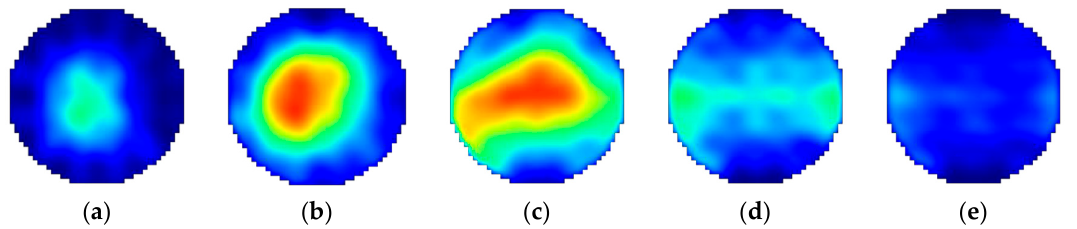
Figure 3. The images ( a – e ) show the reconstruction results of measurements from the hot gas test bench. The images sequence visualizes the ammonia concentration distribution of one urea injection pulse on a flat plate in the hot air stream at a distance of 120 cm downstream of the injection